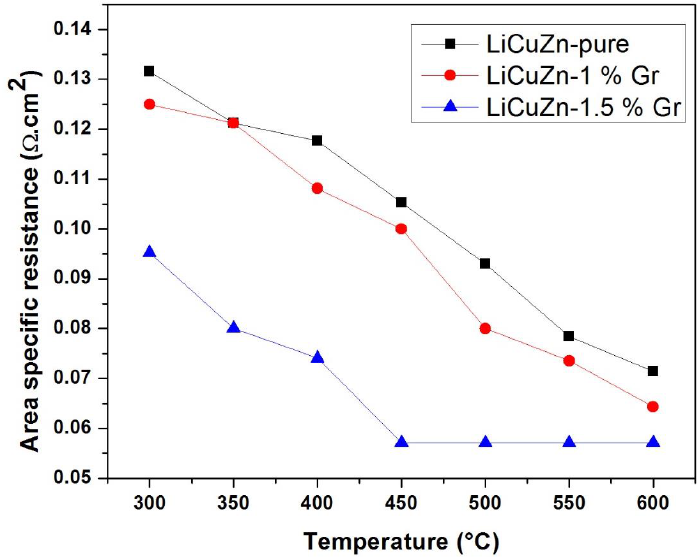
Figure 6. Area-specific resistance (ASR) of prepared cathode.